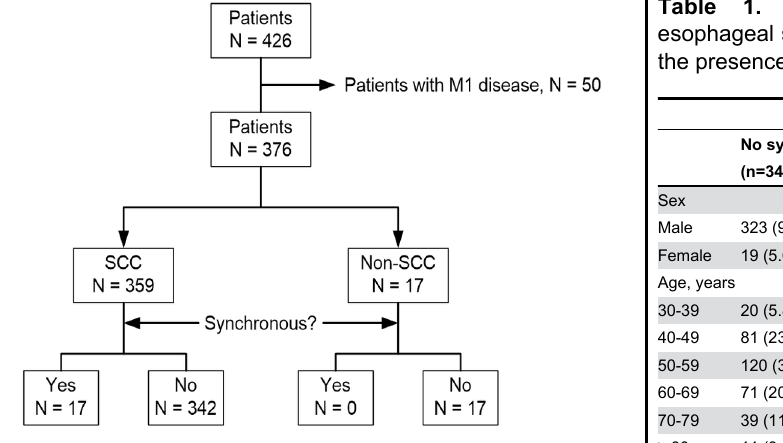
Figure 1. Flow of the patients through the